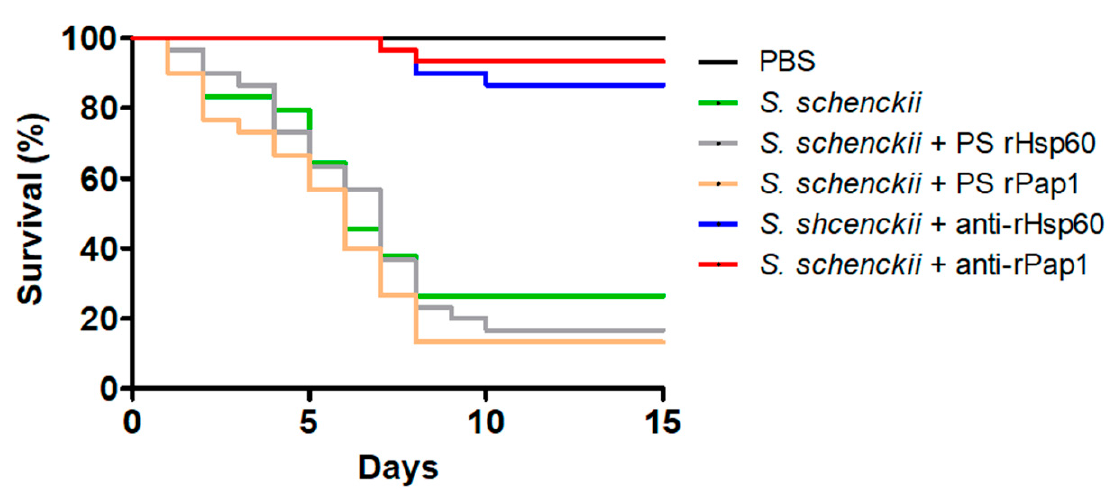
Figure 7. Effect of anti-recombinant Hsp60 and Pap1 antibodies on the Galleria mellonella killed by Sporothrix schenckii. G. mellonella larvae were inoculated with either phosphate-buffered saline (PBS), 1 × 10 5 yeast-like cells ( S. schenckii ), or fungal cells pre-incubated with pre-immune sera (PS) of hosts where anti-rHsp60 or anti-Pap1 antibodies were produced or pre-incubated with polyclonal anti-rHsp60 or anti-rPap1 antibodies ( S. schenckii + rHps60 and S. schenckii + rPap1, respectively) and kept at 37 °C, and mortality was recorded daily. Pre-immune sera and polyclonal antibodies were used at a working dilution of 1:2000.